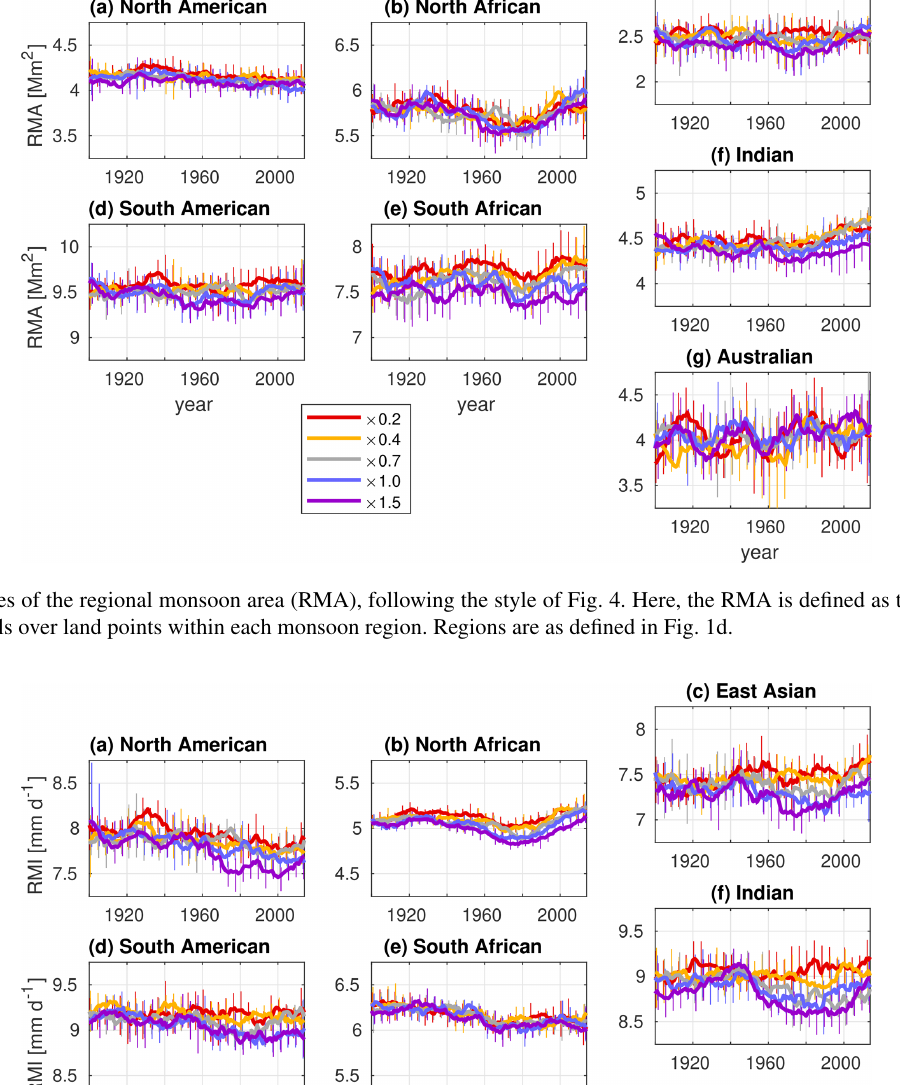
( ∼ 4 %) in both RMA and RMI. In the American and North African regions, the change is dominated by the reduction in RMI; in the South African region, it is dominated by a reduc- tion in RMA. In the Australian region, the RMI reduces but the RMA